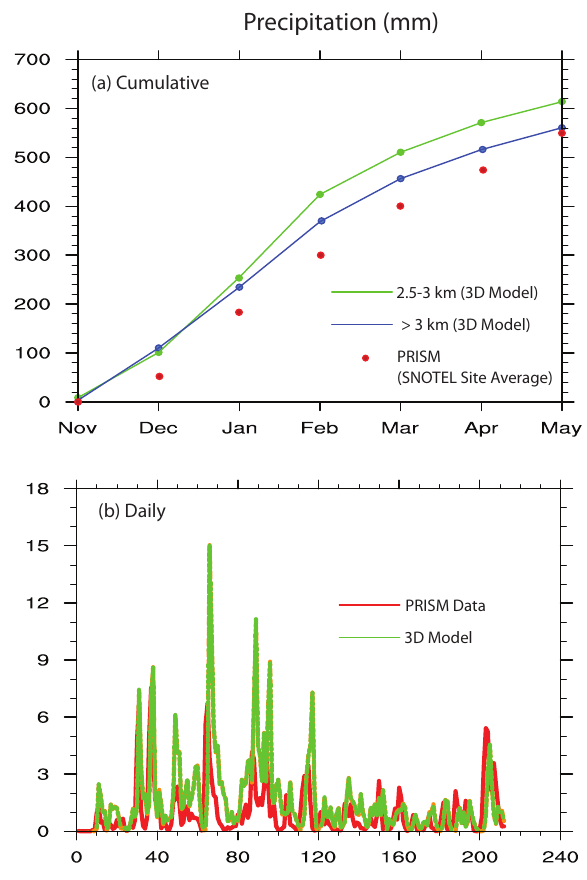
Fig. 3. (a) The domain-averaged monthly cumulative precipitation Fig. 3 simulated from the present model for two elevation zones (2.5–3km and >3km) with the Parameter-elevation Regressions on Indepen- dent Slopes Model (PRISM) data, which are the averaged results determined from cumulative precipitation measured from 112 SNO- TEL sites. (b) The daily precipitation time series (0–240days) com- puted from the 3-D model, along with the PRISM